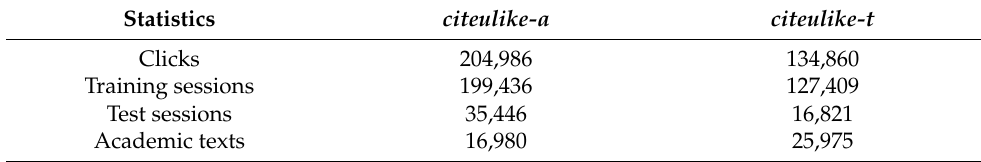
Table 2. Statistics of the experiment